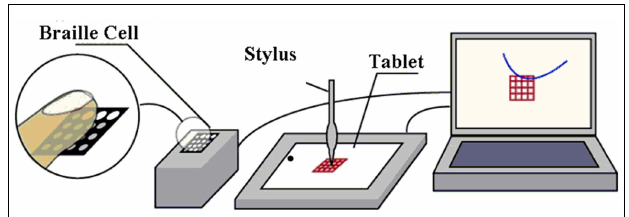
FIGURE 1 |The ‘Tactos’ system. The shapes inscribed in the digital space on the screen are perceived in the tactile mode.The stylus of the graphic tablet controls the movements on the screen of a receptor field.When this receptor field encounters a black pixel, the software triggers an all-or-nothing tactile stimulus on the finger of the non-dominant hand. For the experimental studies presented here we use a single receptor field coupled to an activation of all the tactile pins of the Braille